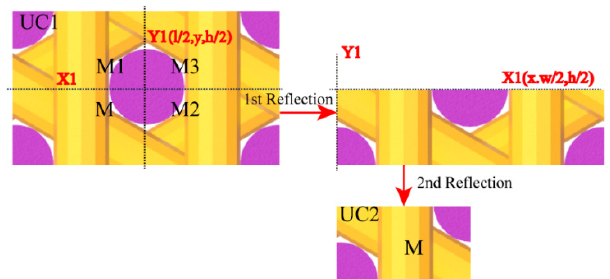
Figure 6. The two rotational transformations of UC2 from UC1.